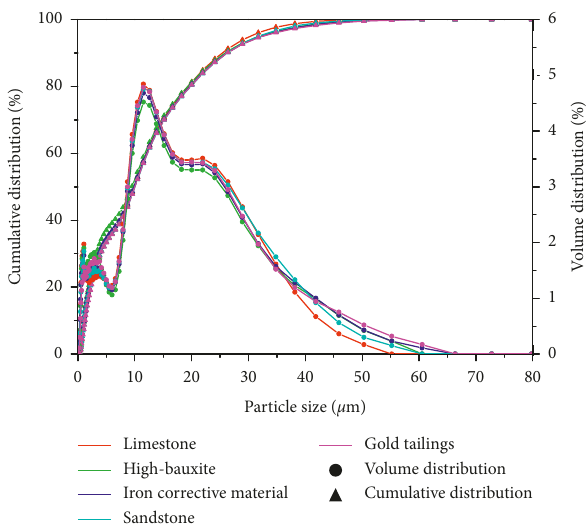
Figure 3: Particle size distributions of five raw